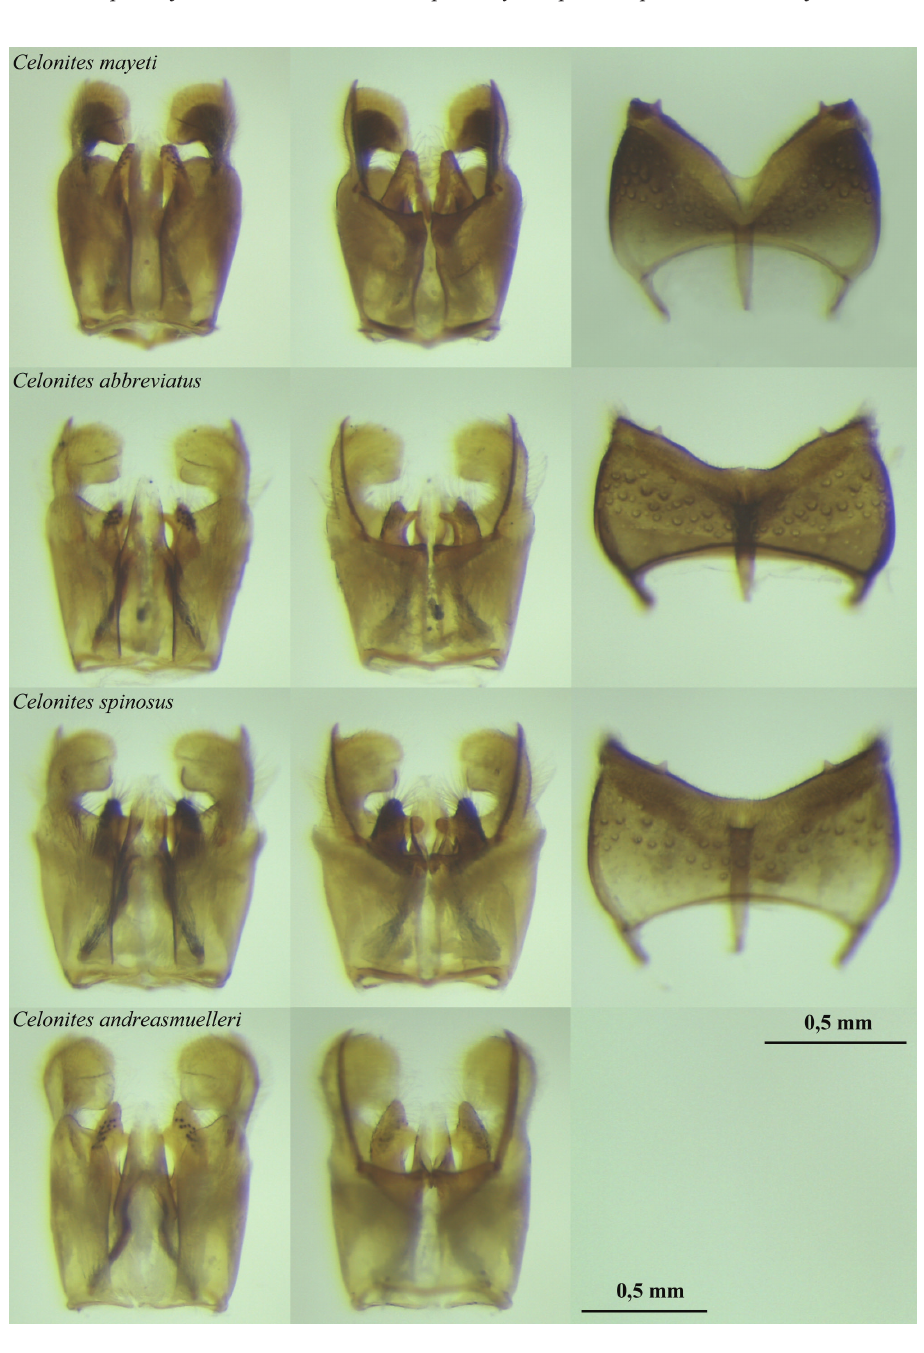
Figure 25. Male genitalia of Palaearctic species of the Celonites abbreviatus -complex in dorsal (left) and ventral view (middle) and metasomal sternum VIII of male in ventral view (right) ( C. mayeti dbM No. 3452; C. abbreviatus dbM No. 3451, C. spinosus dbM No. 3431; C. andreasmuelleri dbM No.